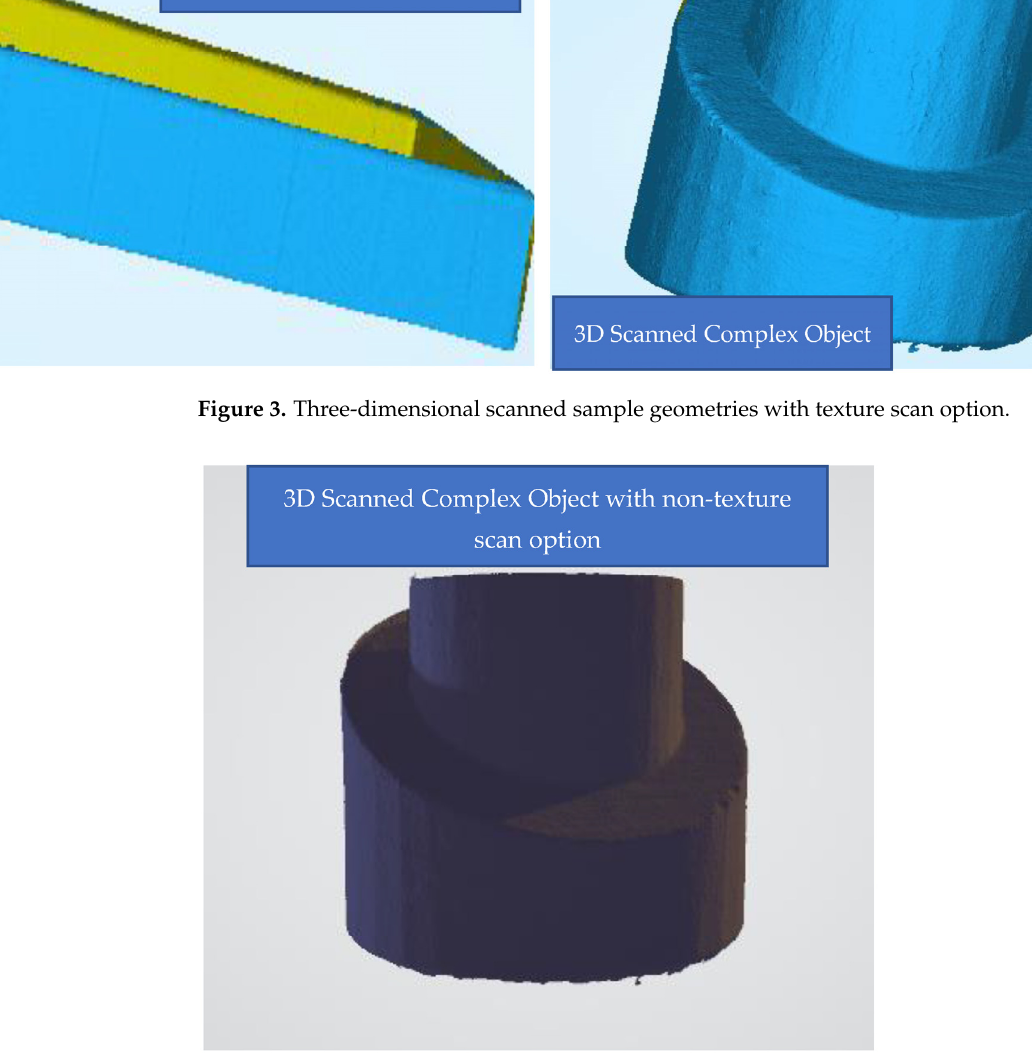
Figure 4. Colorless scanned object from non ‐ texture scan.